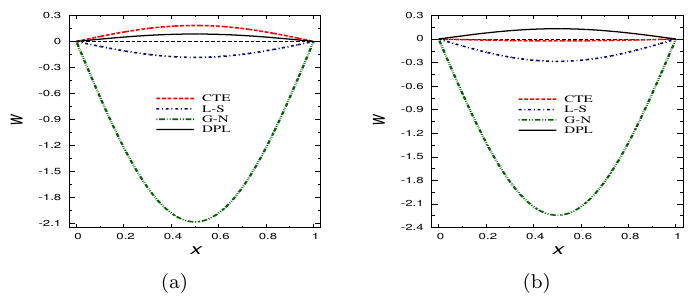
with the L-S one through the upper half-plane of the beam and with the CTE model through the bottom half-plane.